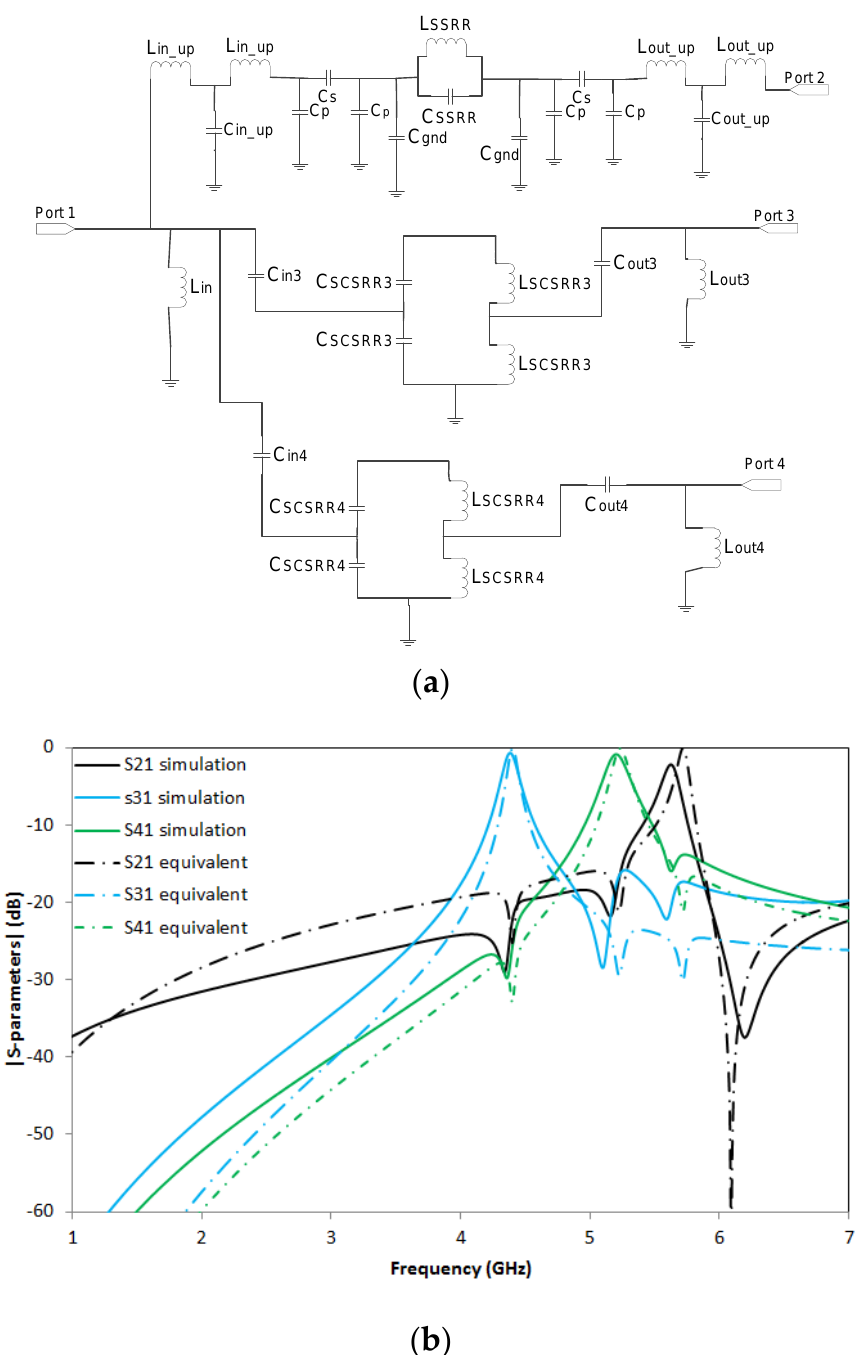
Figure 23. ( a ) Equivalent circuit of triplexer made with SSRR on top and two SCSRRs on ground plane. ( b ) Simulated S21 (dashed black line), equivalent circuit S21 (dashed-dotted black line), simulated S31 (dashed blue line), equivalent circuit S31 (dashed-dotted blue line), simulated S41 (dashed green line), and equivalent circuit S41 (dashed-dotted green line).